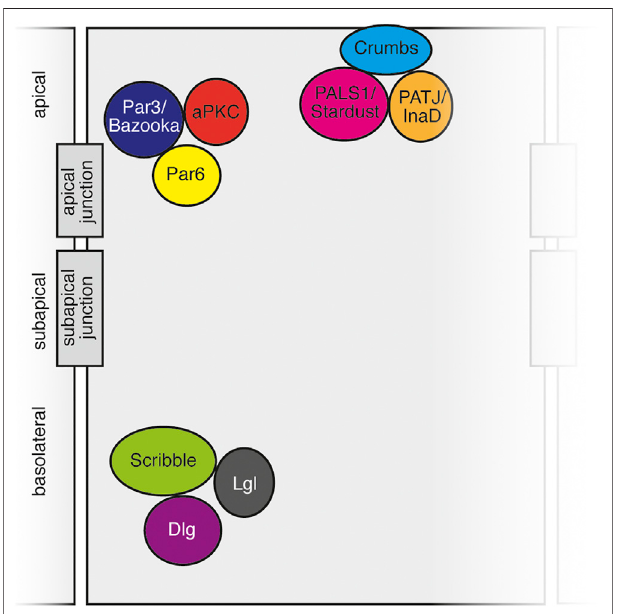
FIGURE 2 | Schematic of polarity complexes in vertebrate and invertebrate cells. Apical Crumbs complex, subapical Par complex, and basolateral Scribble complex depicted with apical junctions (vertebrate tight junctions, invertebrate septate junctions) and subapical junctions (adherens junctions) denoted.